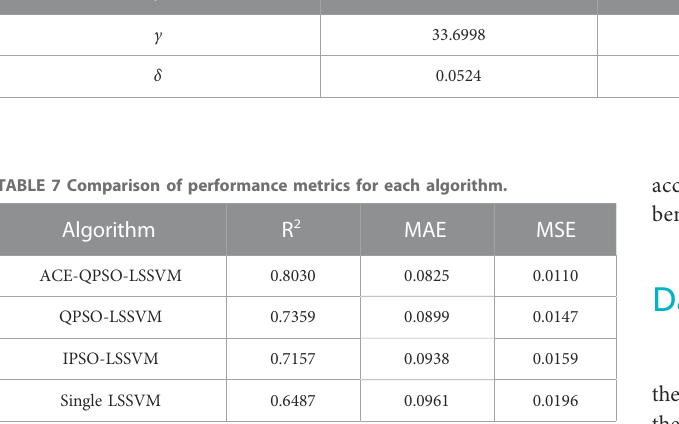
TABLE 6 Estimated parameters fi nally obtained by each algorithm. Estimated parameters